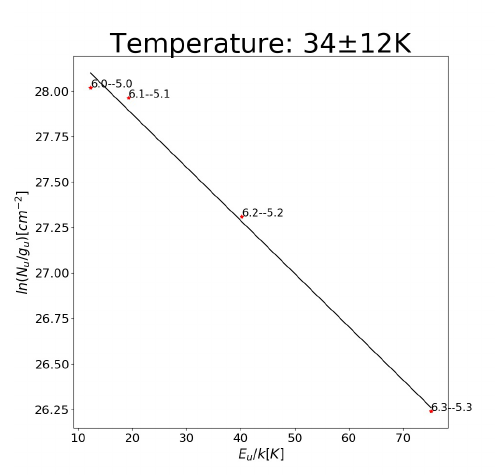
Figure 4. The rotation diagram of CH 3 CCH. Each point represents an energy transition. The derived temperature is 34 ± 12K.